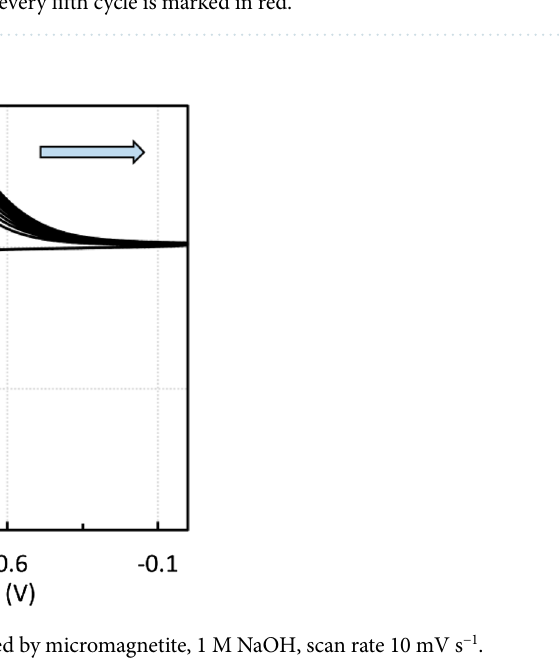
Figure 7. Voltammogram of CPE modified by the sludge residue after leaching in the 0.01 M acetic acid solution, 1 M NaOH, scan rate 25 mV s −1 , every fifth cycle is marked in red.